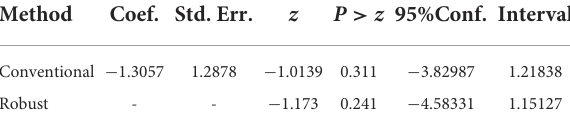
TABLE 9 Placebo test (GDPG as outcome variable). TABLE 10 Placebo test (EXP as outcome variable).